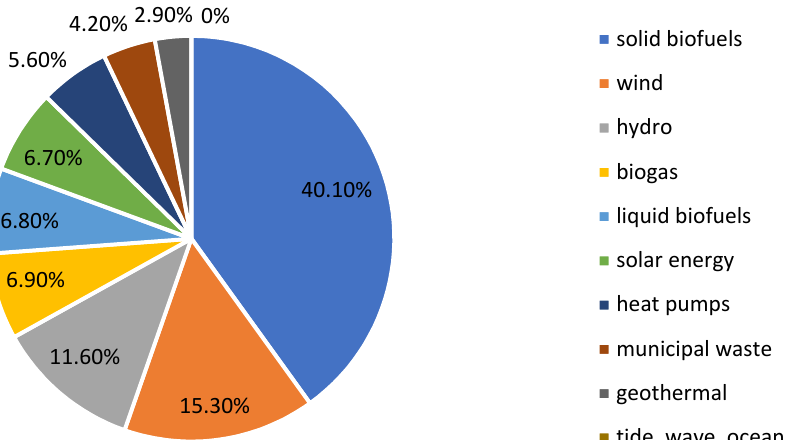
Figure 1. The structure of the alternative energy sources used in the studied countries in 2021.